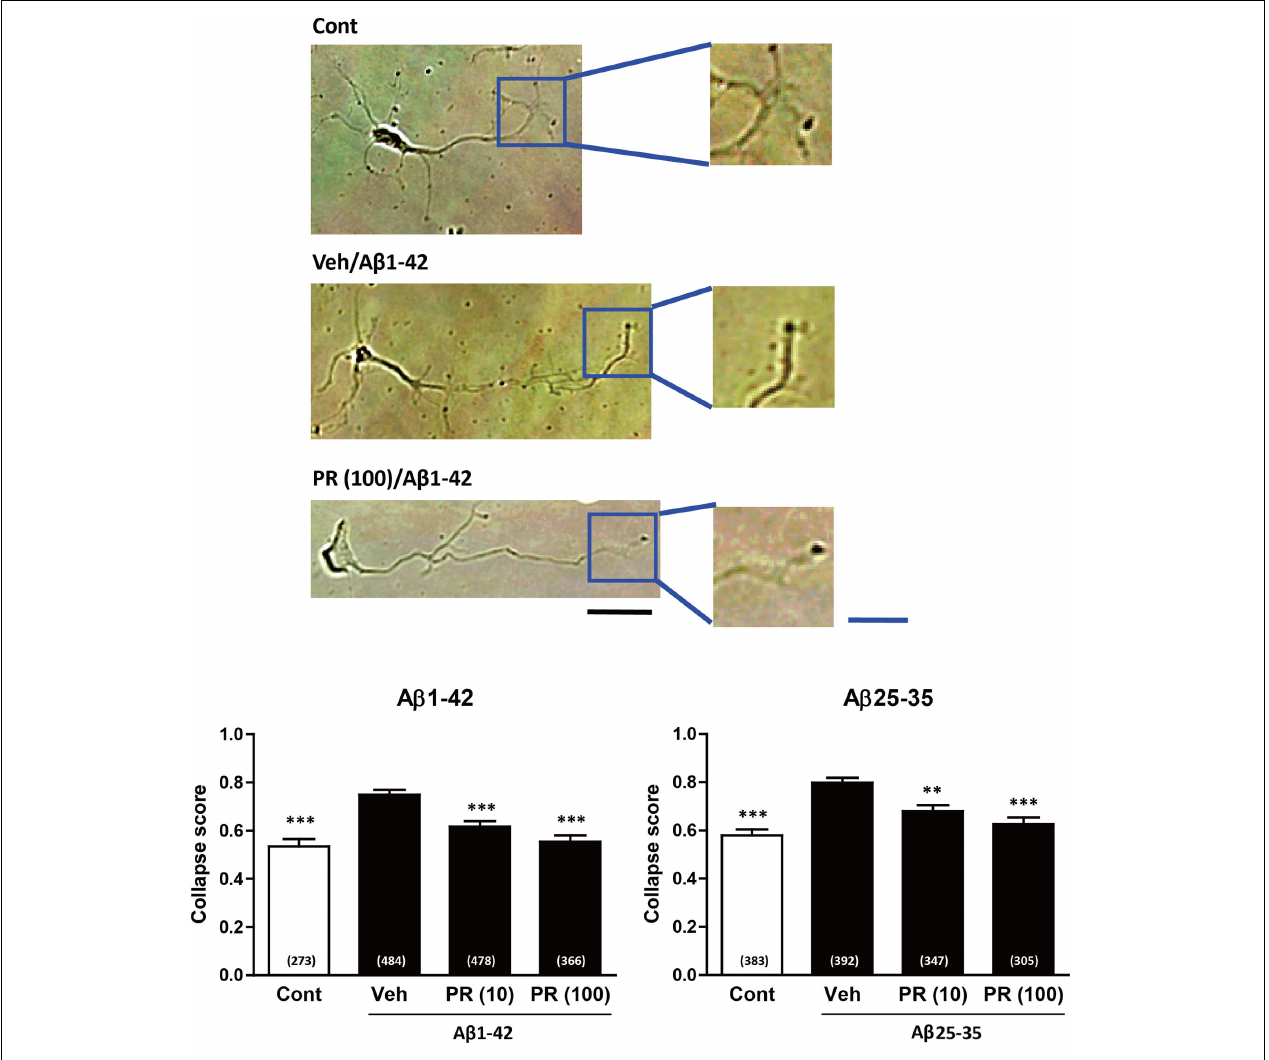
FIGURE 4 | Effects of the Polygalae Radix (PR) extract on amyloid β (A β )-induced growth cone collapse. Cortical neurons were cultured for 3 days, and treated for 30 min with vehicle solution (Cont, Veh) or PR extract [at doses of 10 or 100 µ g ml − 1 ; PR (10), PR (100), respectively]. Next, they were treated with vehicle solution (Cont), A β 1–42 (1 µ M), or A β 25–35 (10 µ M) for 1 h. The neurons were then fixed. Representative bright field images with oblique illumination are shown (upper) . Black scale bar, 20 µ m. Blue scale bar, 10 µ m. The growth cone shapes were quantified as collapse scores. The mean values of the data are presented together with the standard error (lower) . The numbers in parentheses indicate the measured numbers of growth cones. ∗∗ P < 0.01, ∗∗∗ P < 0.001 vs. Veh/A β ; Dunn’s multiple comparison